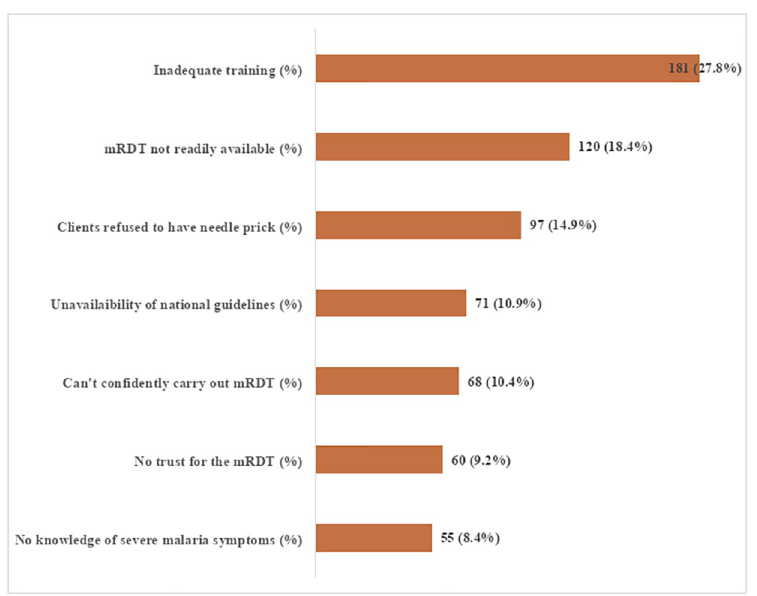
Fig 3. Challenges primary healthcare workers face with malaria